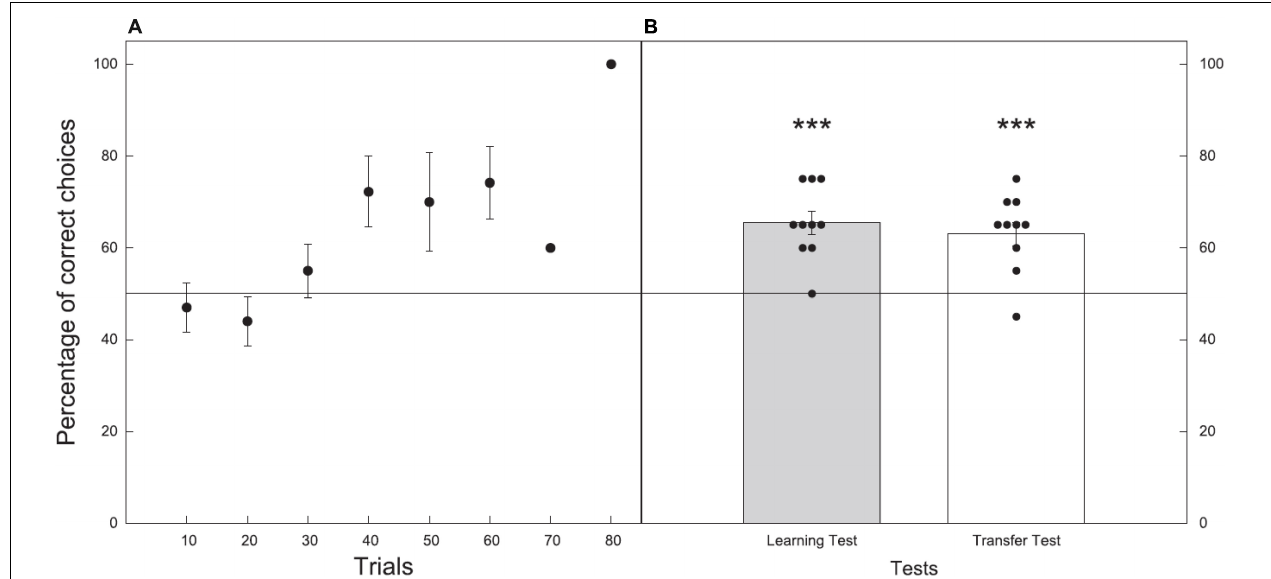
FIGURE 7 | Performance during the learning and test phases for Experiment 2 where bees were trained and tested on their discrimination of 11 vs. 12. Data shown are means ± (SEM). N = 10 bees were used. Black line at 50% indicates the chance level performance. (A) Results of the learning phase (before reaching criterion) with just one bee still learning in trial blocks 70 and 80. (B) Results of the learning (gray) and transfer (white) tests. Black circles show individual results of each bee in the tests. Significance from chance level performance is indicated by *** ≥ 0.001. There was no significant difference between the learning and transfer